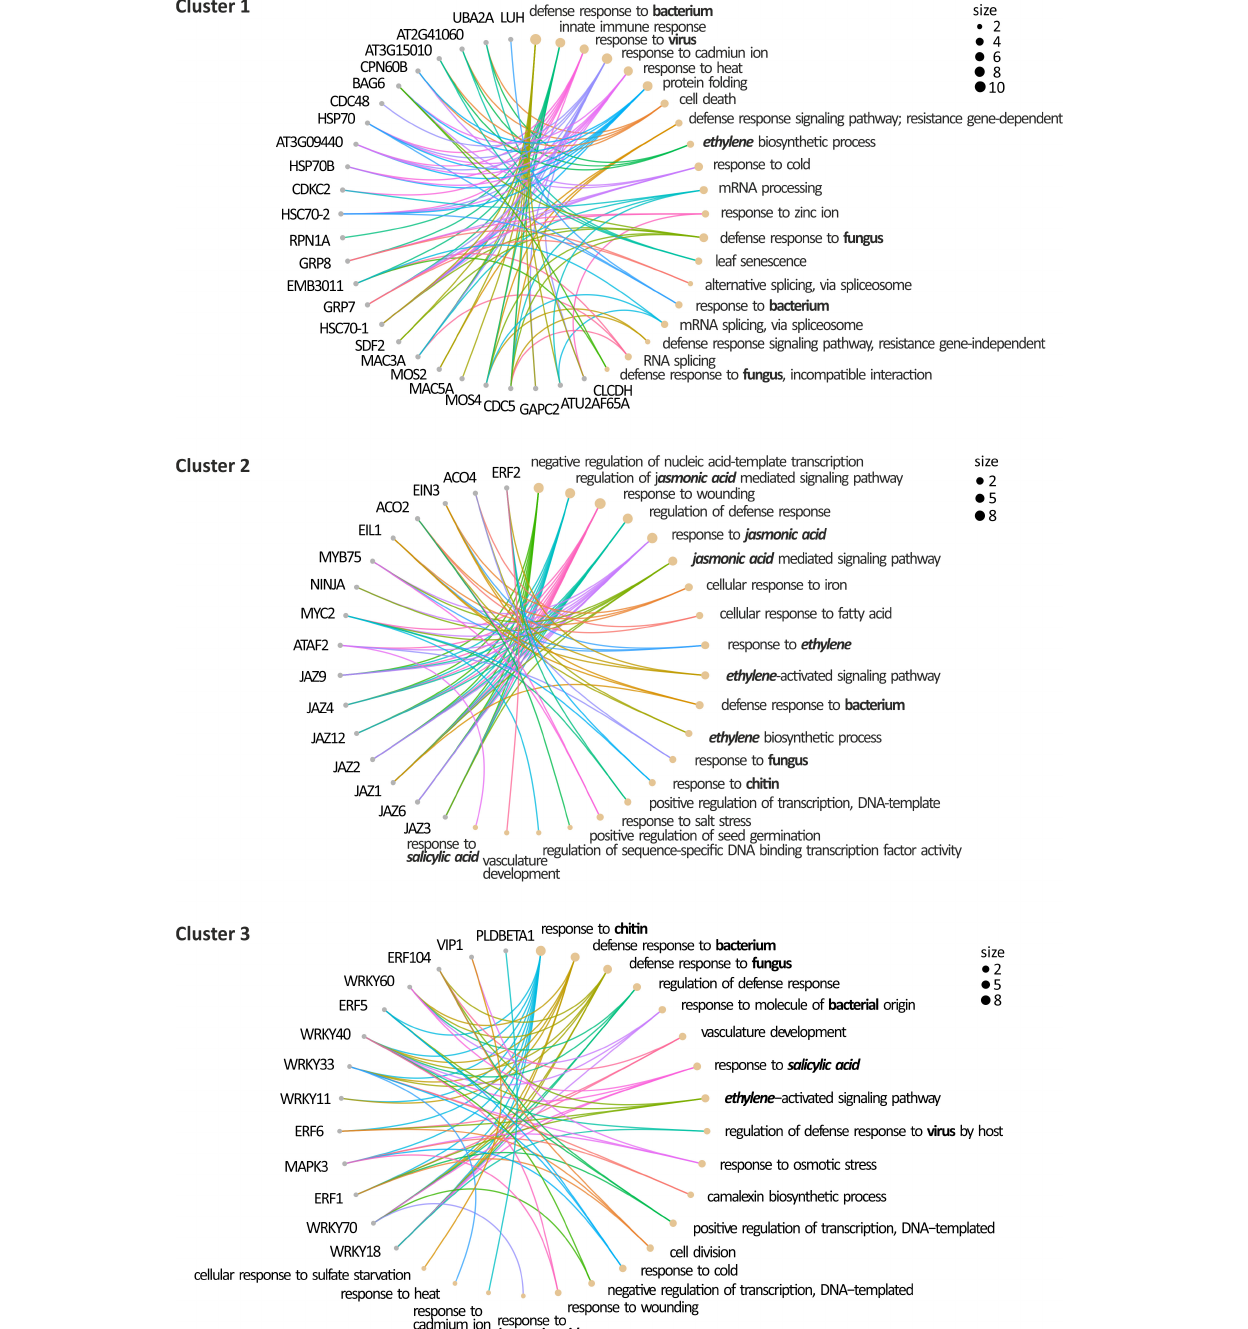
Frontiers in Cell and Developmental Biology |